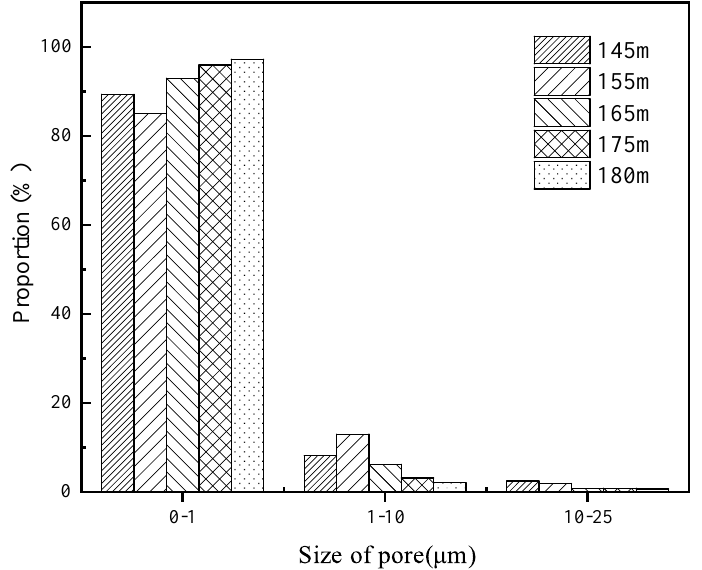
Figure 9. Pore size ratio of soil at different elevations. Figure 9 shows that the soil mass at different elevations contains small pores, medium pores, and large pores. The small pores account for the highest proportion, which is above 85%, and the large pores account for the lowest proportion, which is all less than